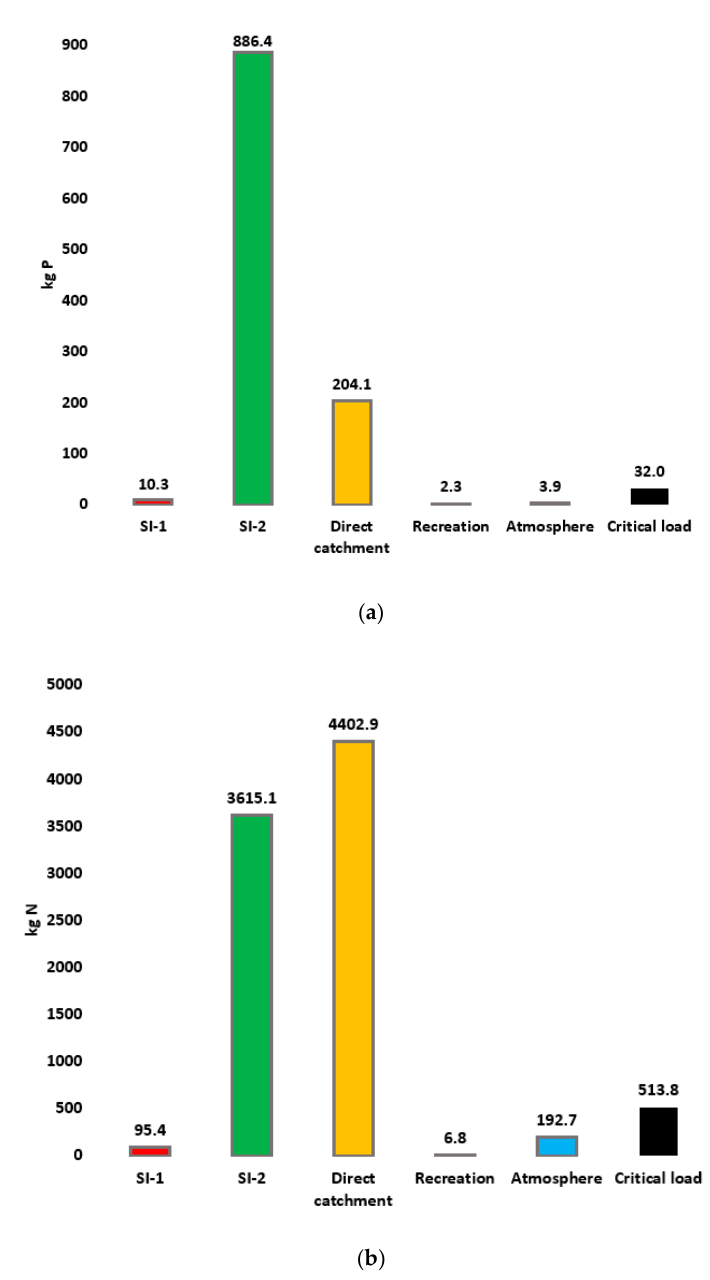
Figure 3. ( a ) Annual (2018) load of phosphorus (kg P) entering Mi ł kowskie Lake from different sources and dangerous load. ( b ) Annual (2018) load of nitrogen (kg N) entering Mi ł kowskie Lake from different sources and dangerous load.